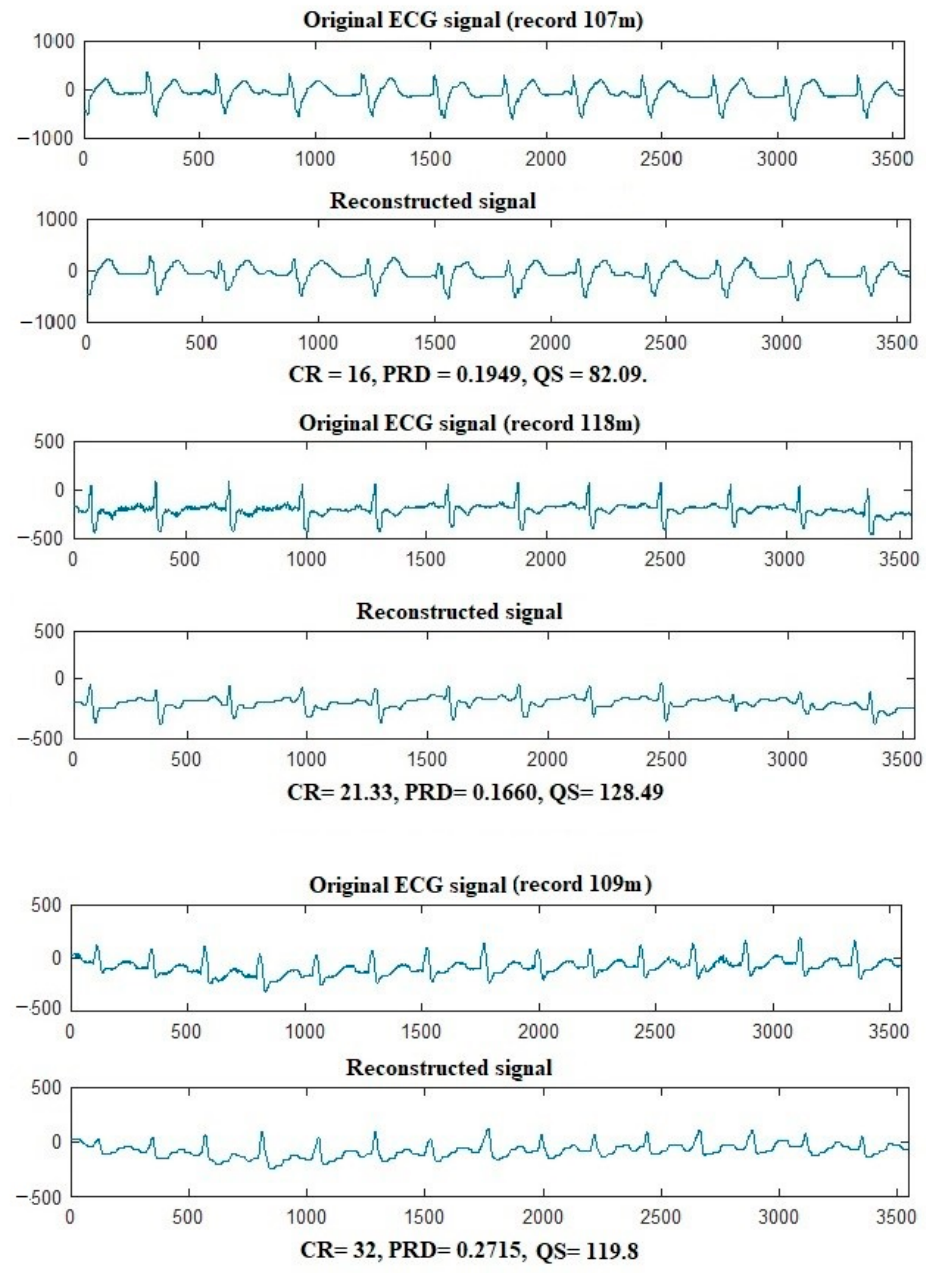
Figure 4. Here, 107, 118, and 109 ECG records compression with the suggested Figure 4. Here , 107, 118, and 109 ECG records compression with the suggested algorithm. Table 2. Result of EEG signal compression using the proposed algorithm.